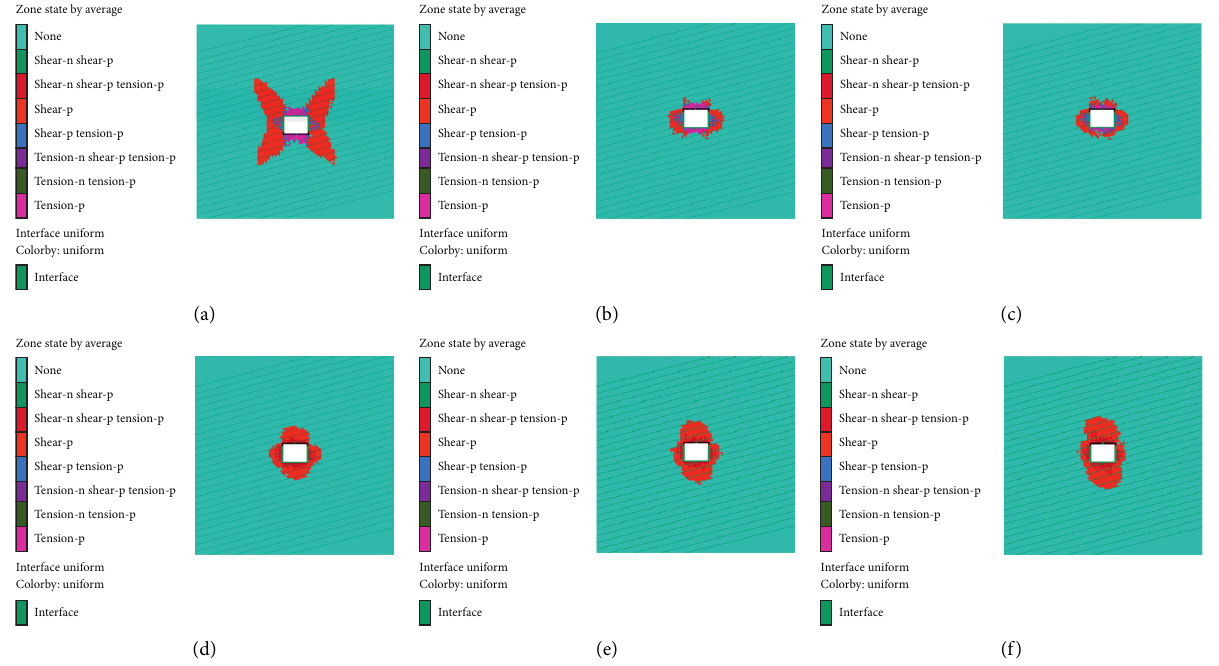
Figure 9: Distribution pattern of plastic zone under different lateral pressure coefficients. (a) λ � 0.3. (b) λ � 0.6. (c) λ � 1.0. (d) λ � 1.5. (e) λ � 2.0. (f) λ �